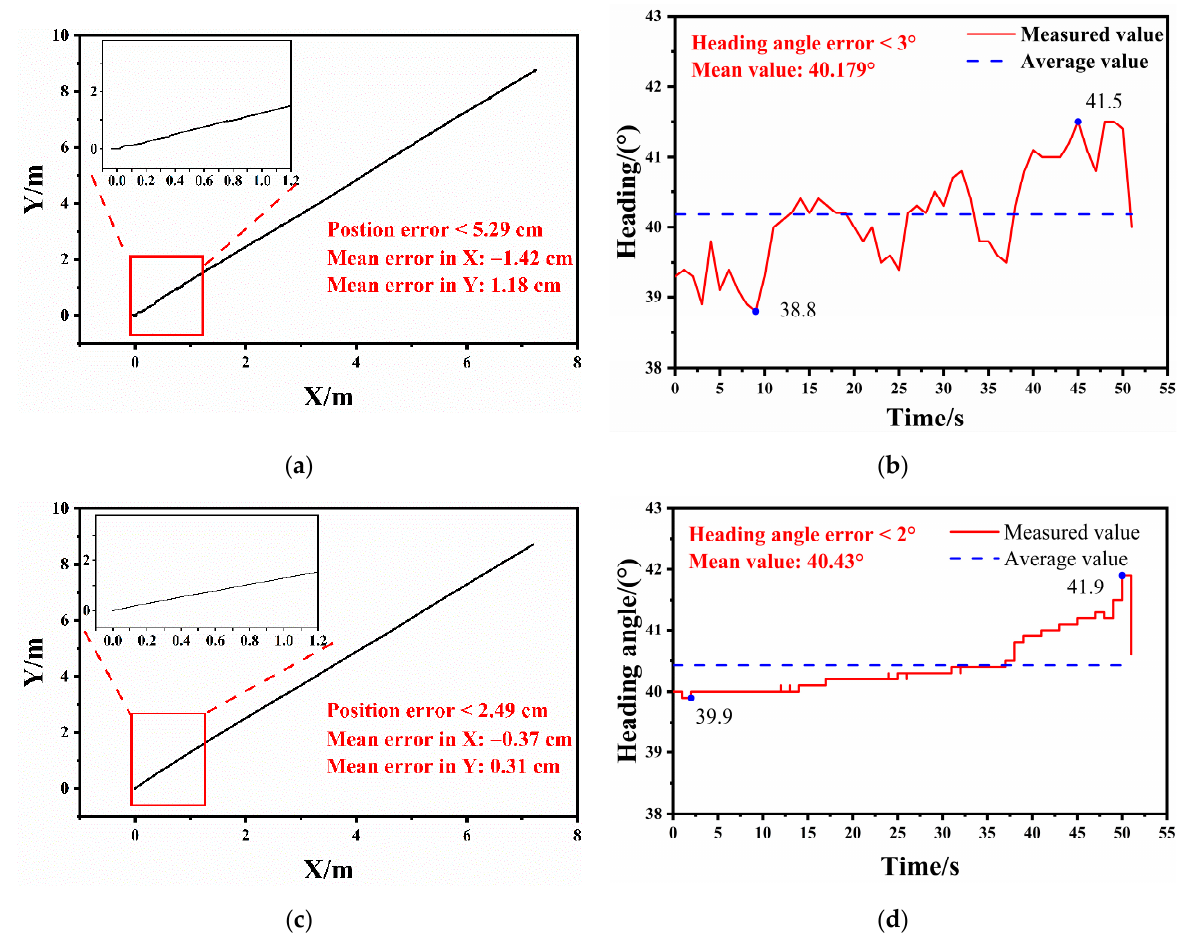
Figure 11. The positioning results of the spraying robot in the straight-line running experiments. ( a ) Positioning measurements using BDS; ( b ) Heading angle measurements using BDS; ( c ) Positioning measurements using BDS/IMU integrated system; ( d ) Heading angle measurements using BDS/IMU integrated system.